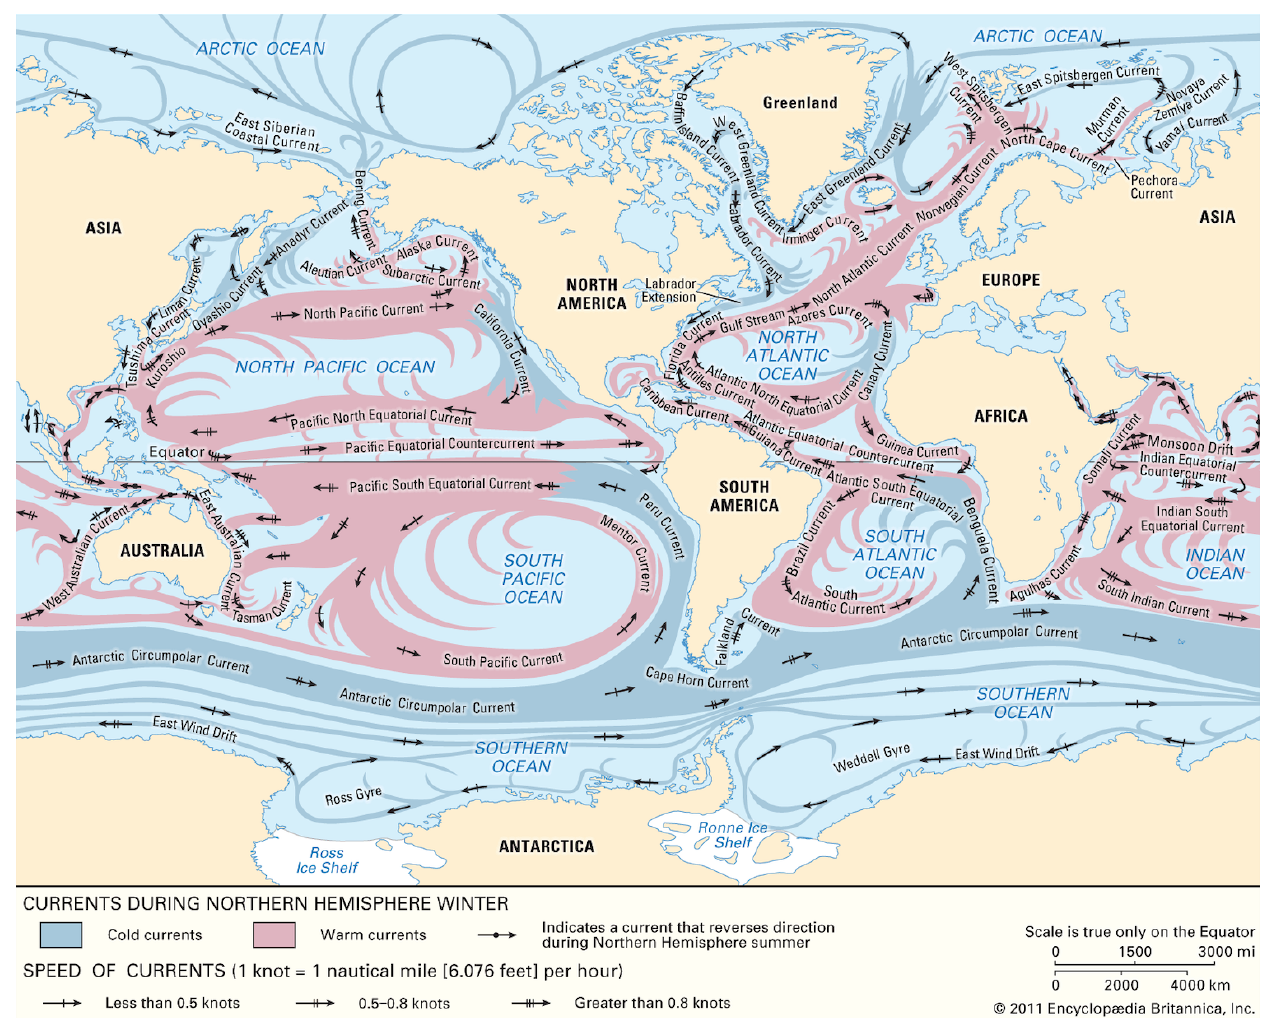
Figure 3. Global surface currents magnitude during northern hemisphere winter by